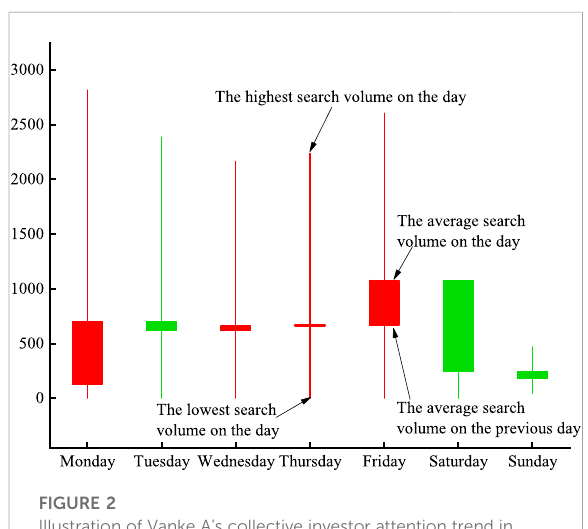
FIGURE 2 Illustration of Vanke A ’ s collective investor attention trend in one sample week. The horizontal axis is the date, and the vertical axis represents the search volume on the